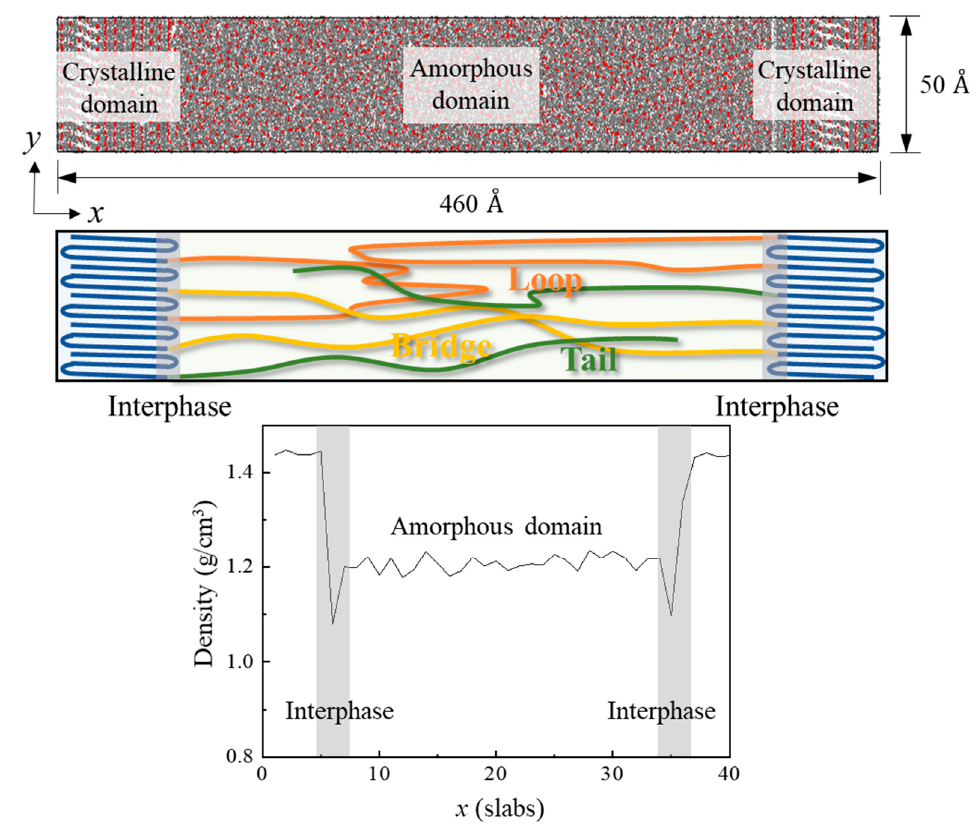
Figure 1. Structure and density of a semi-crystalline PEEK in the periodic boundary condition.